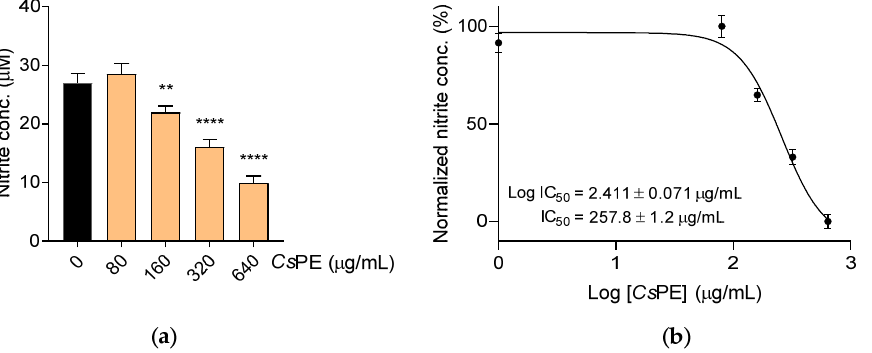
Figure 3. Inhibition of NO release in proinflammatory cultures of LPS-activated RAW 264.7. RAW 264.7 cells were cultured with LPS alone (control, black bar) or in combination with different amounts of Cs PE for 24 h (orange bars). ( a ) NO released in the culture supernatant was quantified as nitrite concentration by using Griess reagent. Results are reported as mean ± SD of three independent experiments, each conducted in triplicate. ** p < 0.01, **** p < 0.0001, LPS/ Cs PE-treated versus LPS-activated cells (one-way ANOVA test). ( b ) A concentration-response curve was obtained to determine the IC 50 of Cs PE. The IC 50 value was determined using non-linear regression